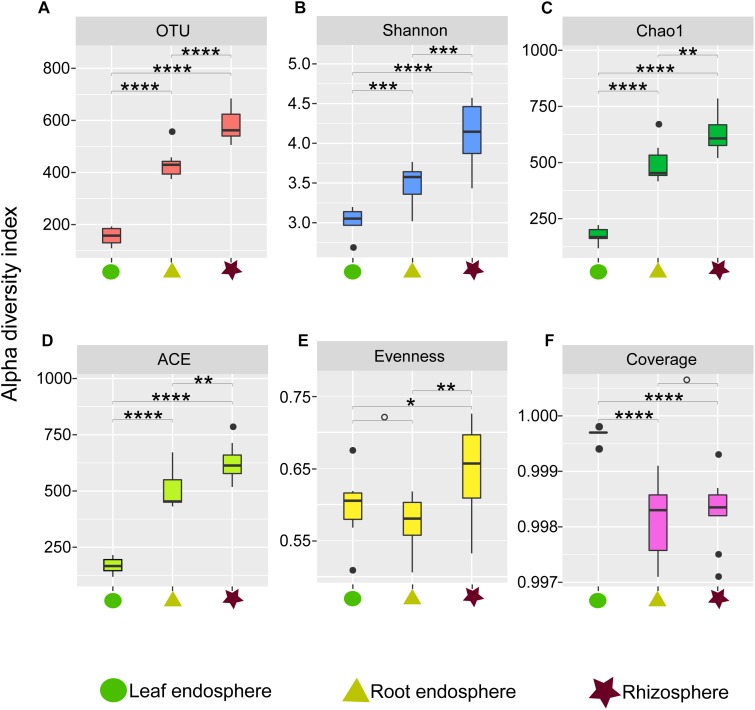
Alpha diversity estimates of the fungal communities in different plant compartments. (A) Number of observed OTUs. (B) Shannon diversity. (C) Chao1. (D) ACE value. (E) Pielou’s evenness. (F) Good’s coverage scores. One-way ANOVA with Tukey’s HSD tests were performed to reveal significant differences in alpha diversity among the plant compartments. O, No significant; ∗P < 0.05; ∗∗P < 0.01; ∗∗∗P < 0.001; ∗∗∗∗P < 0.0001.